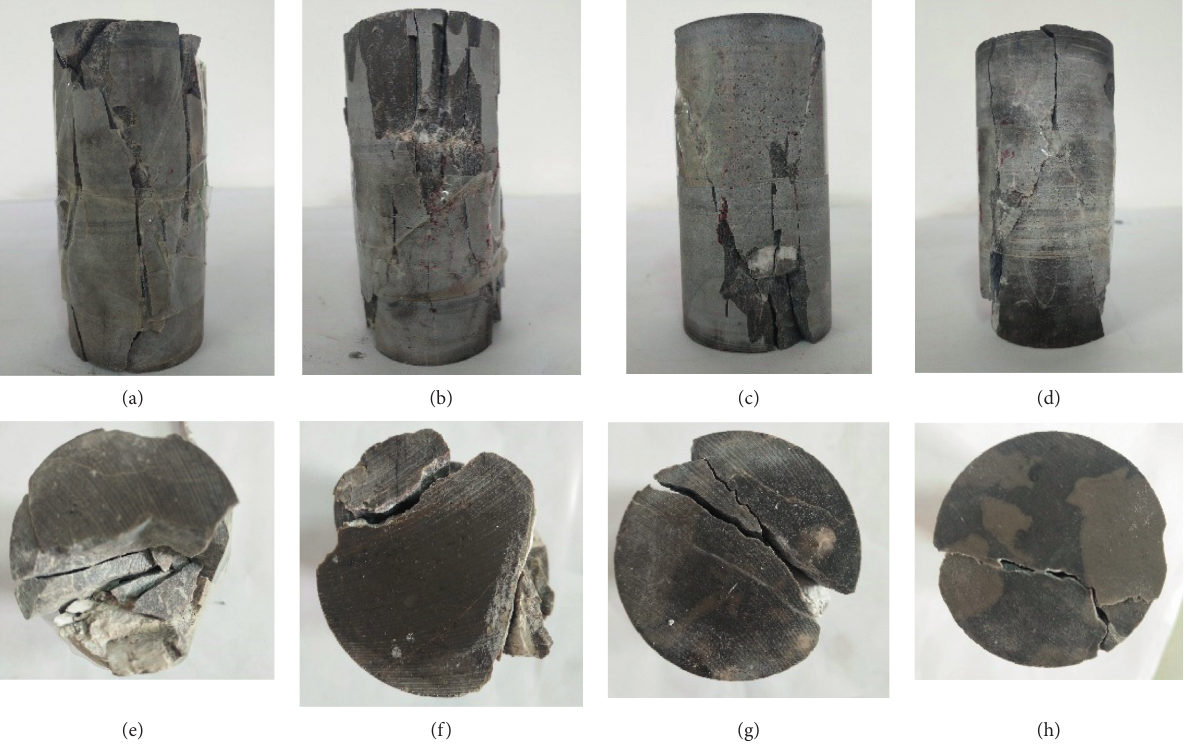
Figure 4: Failure modes of the karst limestone under different strain rates. (a) 5 × 10 − 6 s − 1 . (b) 2 × 10 − 5 s − 1 . (c) 1 × 10 − 4 s − 1 . (d) 5 × 10 − 4 s − 1 . (e) 5 × 10 − 6 s − 1 . (f) 2 × 10 − 5 s − 1 . (g) 1 × 10 − 4 s − 1 . (h) 5 × 10 − 4 s − 1 .